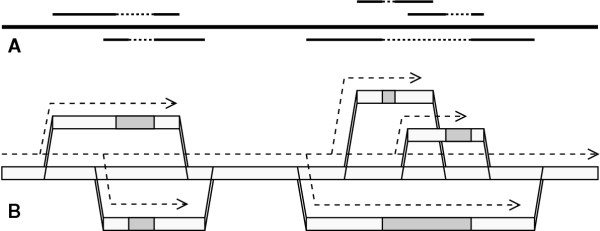
Integration of several incompatible ESTs in EuGène-M's graph and algorithm. A: EST alignments (plain lines represent exons, dotted lines, intron) on a genomic sequence (thick line). Each displayed EST is incompatible with at least another one. B: Multiple extensions of EuGÈNE's graph model after having processed these alignments. Each PGS (Figure 3) contains the information provided by its source EST. The dotted arrows show the algorithm progression through the resulting graph during the first scan, from the left to the right.